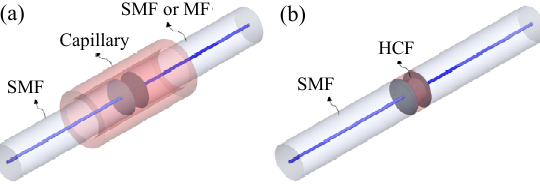
Fig. 15 Schematic diagrams of sandwich-type EFPI structure: (a) capillary-based and (b)